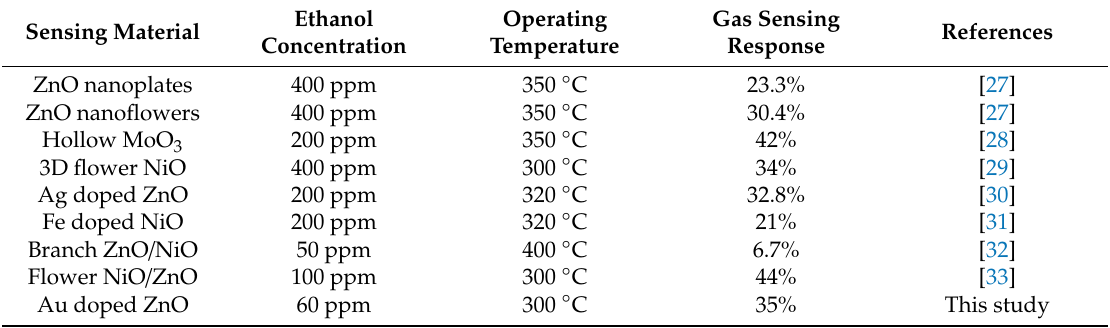
Table 1. Comparison of ethanol gas sensing response from di ff erent literature work and current study. Sensing